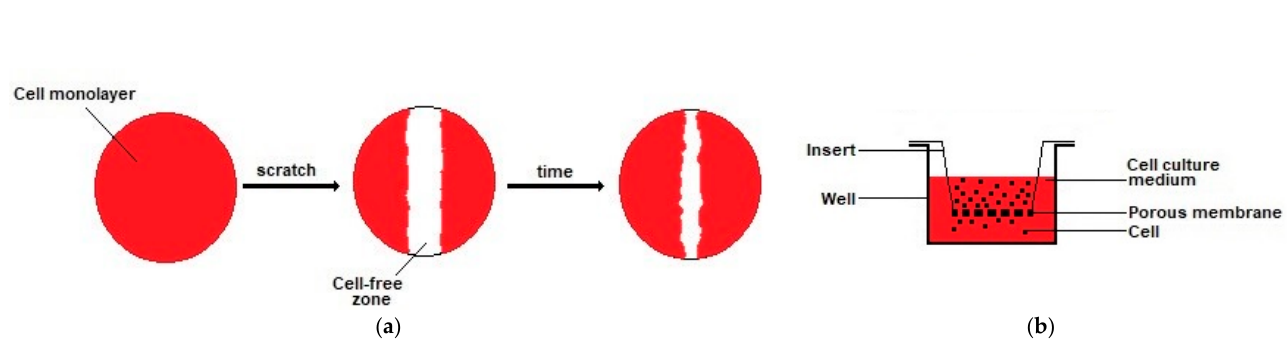
Figure 8. Schematic representation of the in vitro assays employed in the evaluation of the wound- healing capacity of PRM6. ( a ) Wound-scratch assay, in which a linear gap is created in a cell monolayer by scratching the monolayer with the tip of a sterile pipette tip. The WD is assayed by applying extracts in cell culture medium to the cell monolayer. ( b ) Boyden’s chamber assay (also known as transwell migration assay or chemotaxis assay), in which a cell suspension is contained in hanging inserts with a porous membrane that are immersed in cell culture medium. The WD is assayed by applying extracts in cell culture medium to wells. After incubation, cells that migrate into the well are counted.